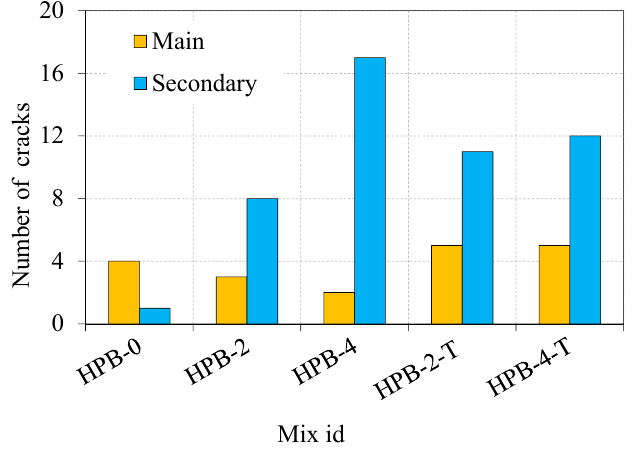
Figure 15. The observed number of cracks under impact loading.